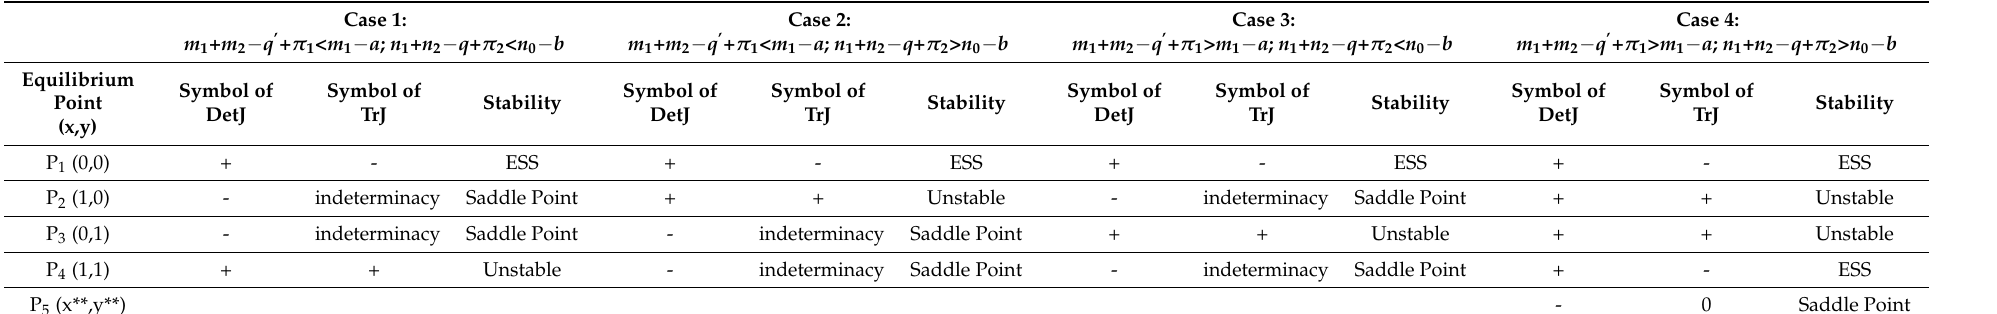
Table 4. Local stability of equilibrium